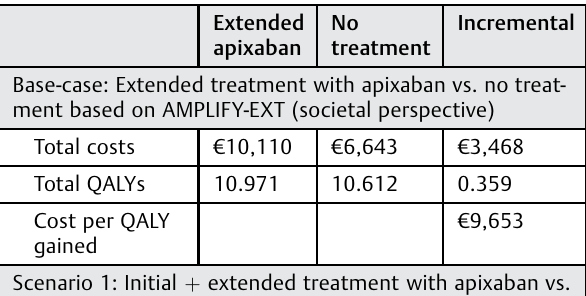
Table 3 Costs and effects per patient and incremental cost- effectiveness ratios in the base-case and scenario